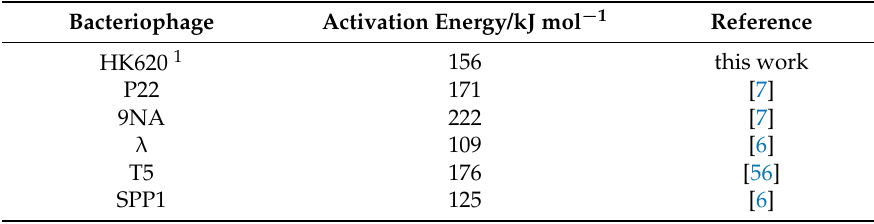
Table 2. Activation barriers found for in vitro bacteriophage particle